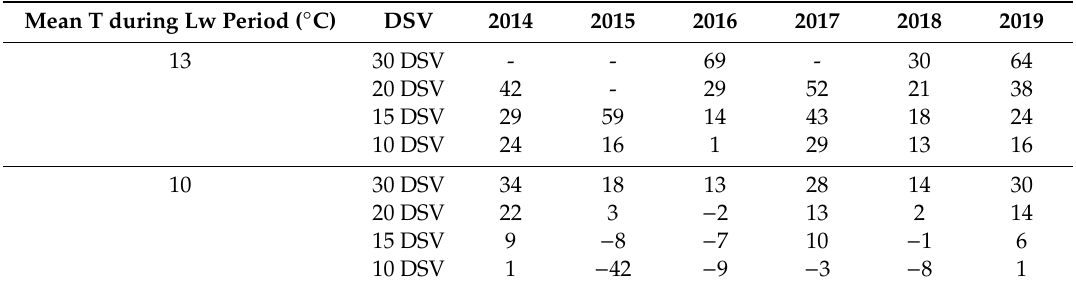
Table 8. Proposed adjustment of the TOMCAST model for the growing conditions of A Limia. Mean T during Lw Period ( ◦ C)